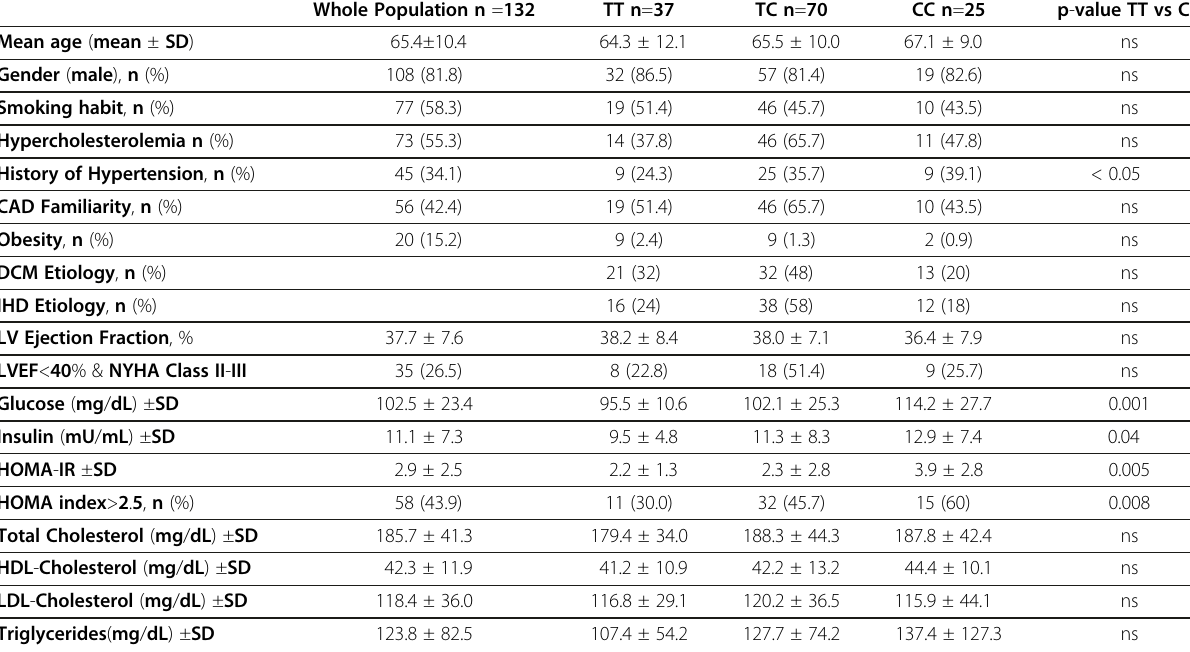
Table 1 Demographic and clinical characteristics of study population Whole Population n = 132